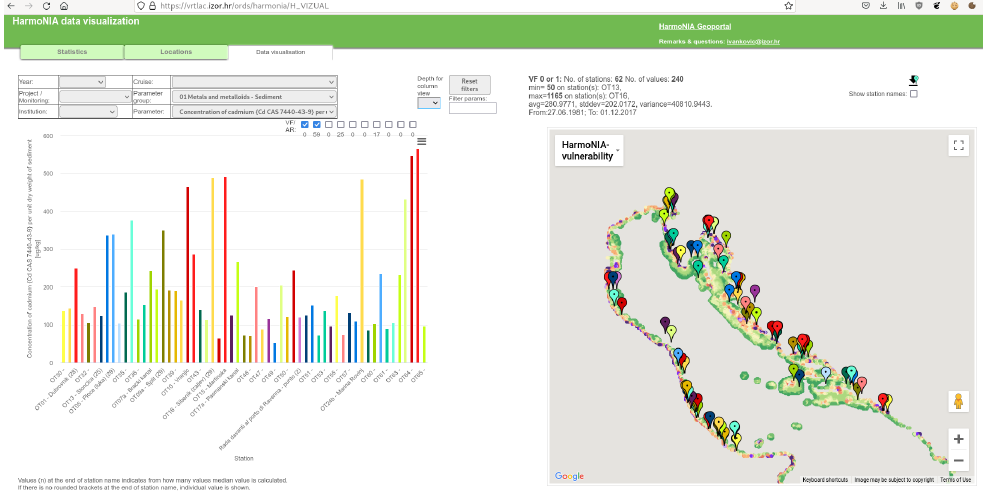
Figure 11. Custom base layer